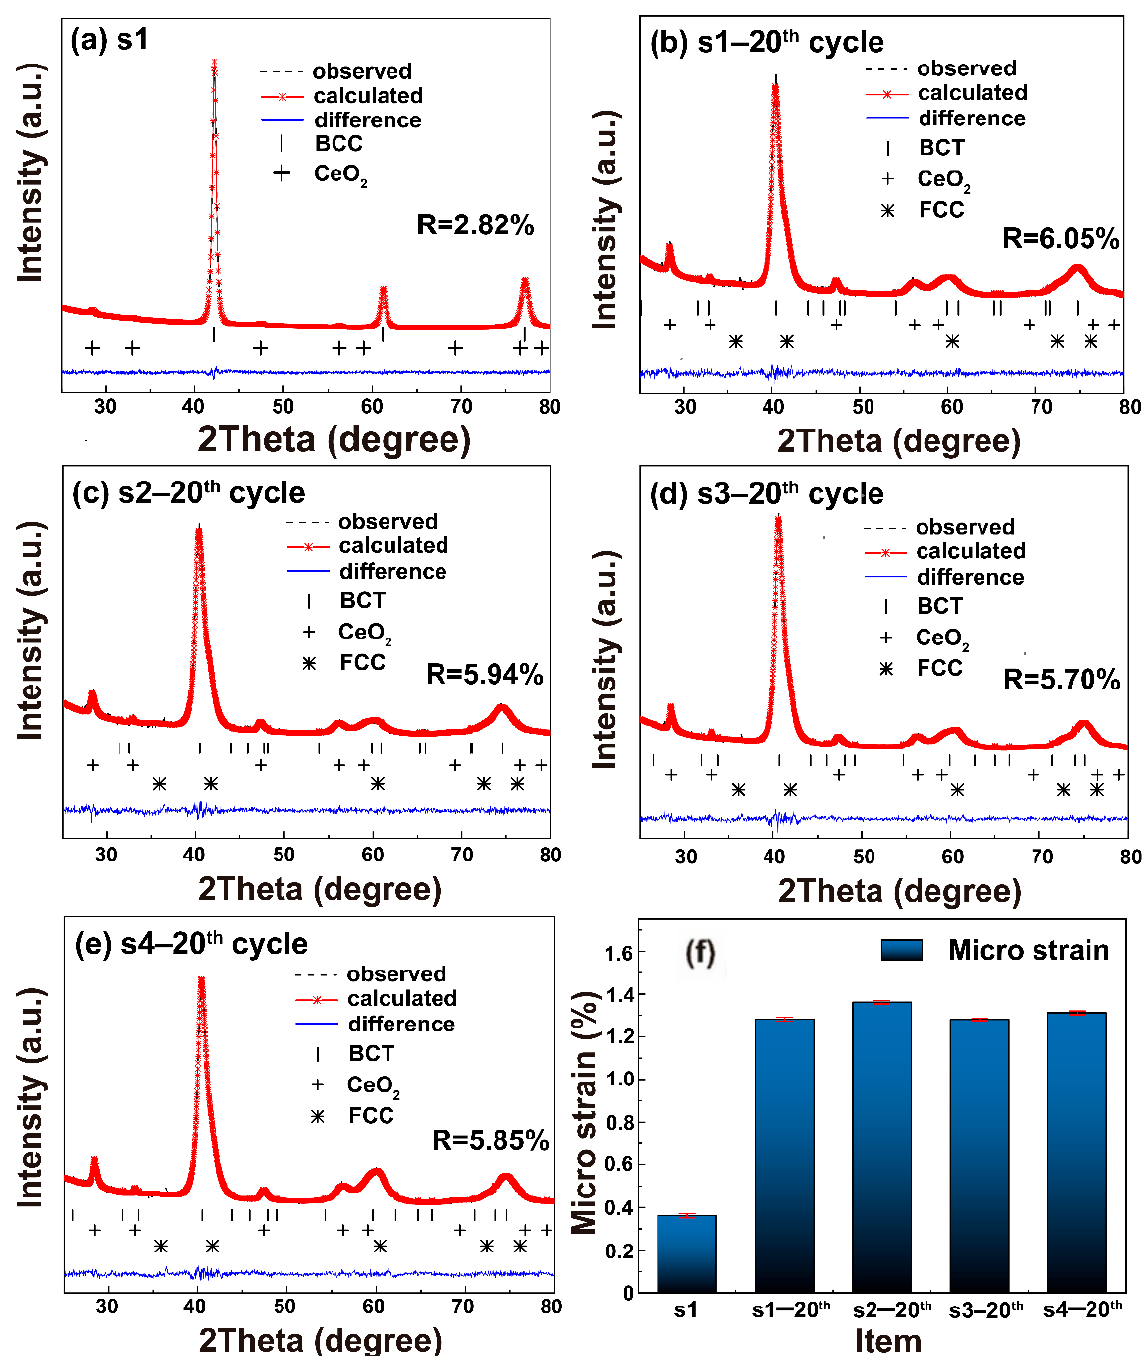
Figure 4. ( a – e ) Rietveld refinement of the XRD data of sample s 1 and samples s 1 to s 4 after 20 hydrogen ab/desorption cycles and ( f ) microstrains of sample s 1 and samples s 1 to s 4 after 20 hydrogen ab/desorption cycles.